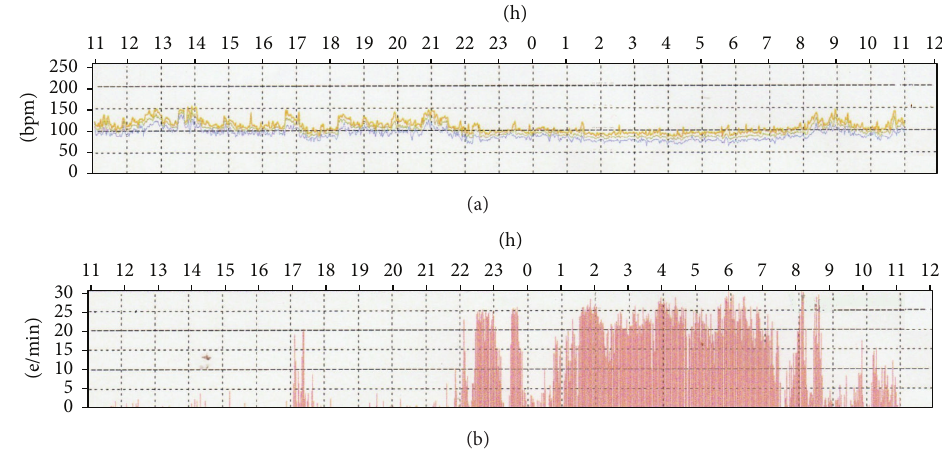
Figure 1: Heart rate (a) and ventricular premature complexes (b) during 24-hour Holter monitoring.